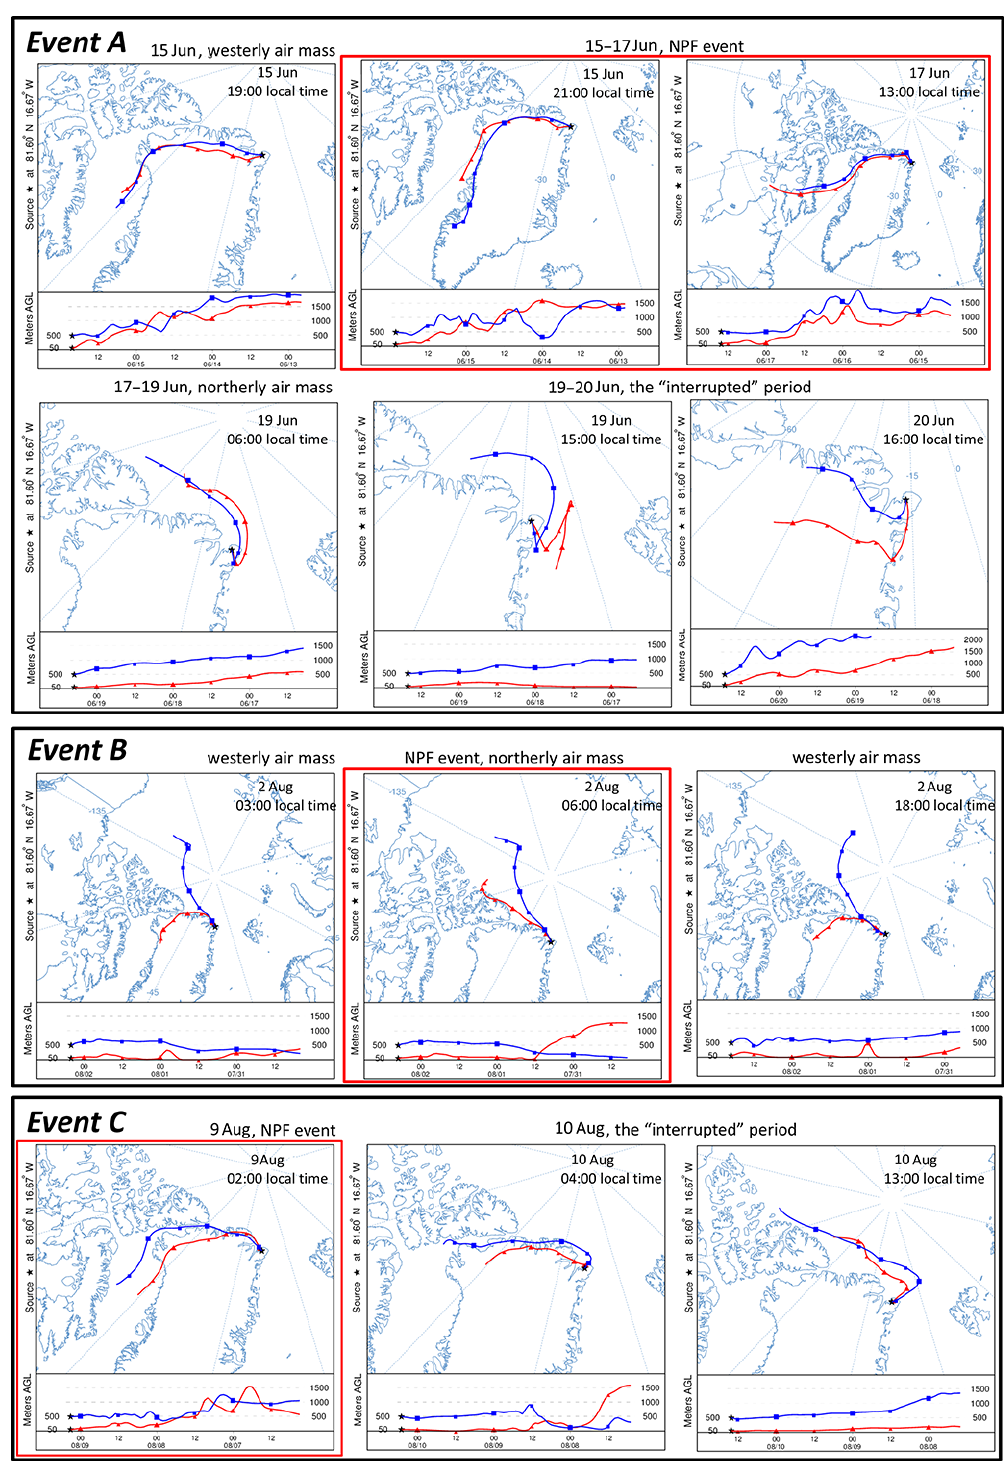
Figure 7. Demonstration of air mass back trajectories calculated hourly using HYSPLIT for arrival at 50m and 500m at the station for the case study